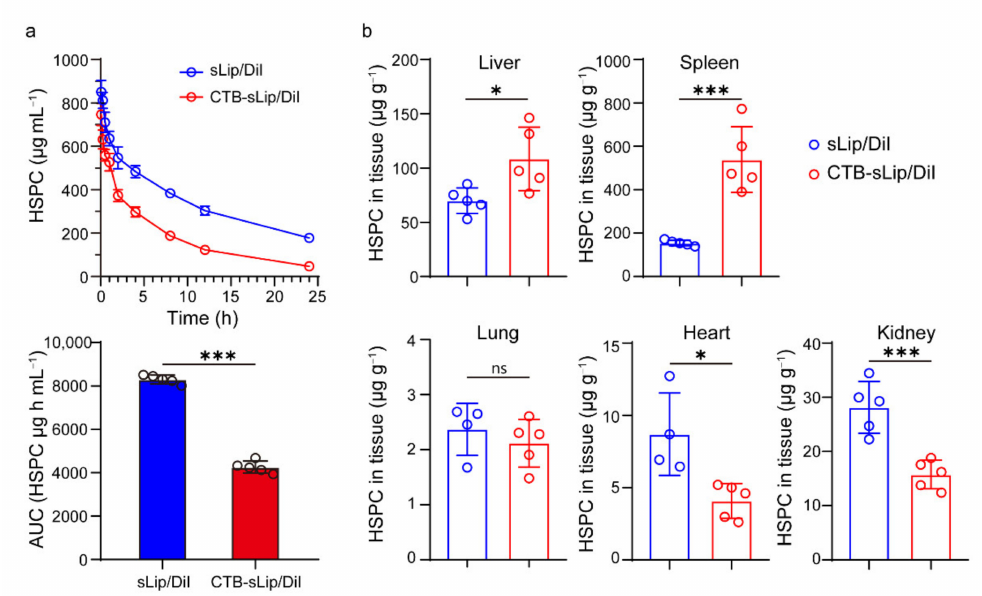
Figure 5. Pharmacokinetic profiles ( a ) and biodistribution ( b ) of sLip/DiI and CTB-sLip/DiI in major organs of BALB/c mice over 24 h after intravenous injection with 50 mg kg − 1 lipids. Data are means ± SDs, n = 5. * p < 0.05, *** p < 0.001; ns indicates non-significant based on Student’s t -tests.